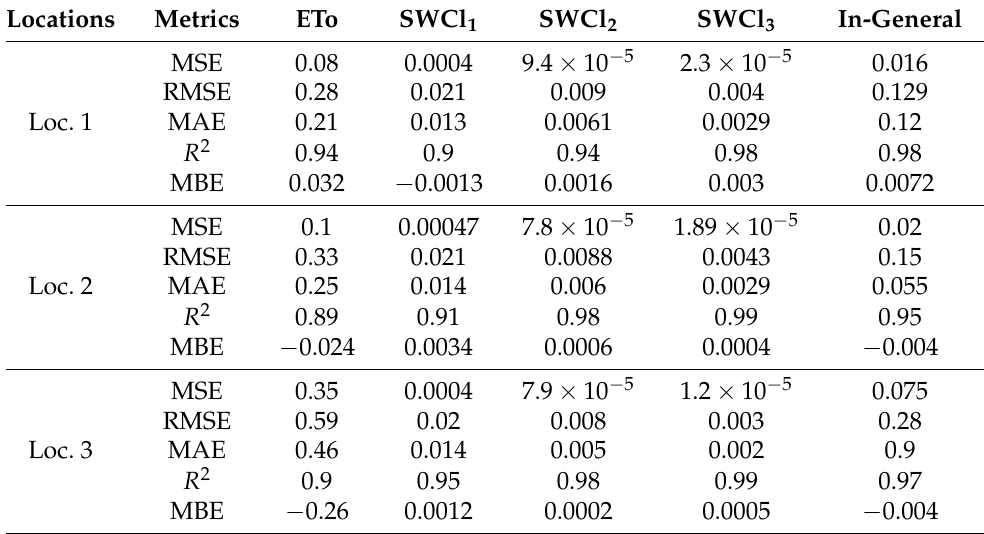
Table 6. Evaluation of the LSTM model on the test set for each site. The model was trained on two datasets and tested on the third dataset.